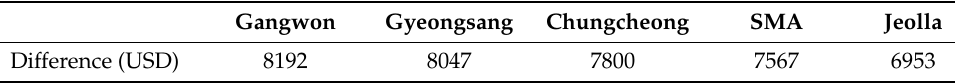
Table 10. Difference in profit between APV installation by region.